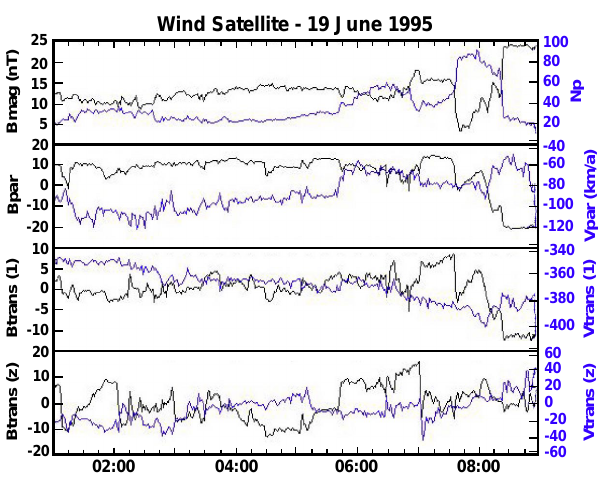
Fig. 13. PSD for Wind (top panel) and KIL (bottom panel) on 19 June 1995. Figure 13 shows the power spectral density (PSD) associ- ated with the parallel (compressional) component at Wind (top panel) and the H component at KIL (bottom panel). These are the same components as were used in Fig. 2 (top panel). The color scales are different in each panel in Fig. 13, in order to pull out the peaks in the spectrum. The KIL power bands are somewhat wider than those at Wind due to the resolution of the data. There are general trends in the two panels that are similar: an enhancement in power be- tween 0 and 4 mHz at the beginning of the plot; a depletion in PSD between 03:00 UT and 05:00 UT (top) and between 04:00 UT and 06:00 UT (bottom); and increased PSD be- tween 06:00 UT and 09:00 UT (top) and between 07:00 UT and 10:00 UT (bottom). The peaks in PSD occur in the fre- frequency for KIL ∼ 06:00 UT, ∼ 07:30 UT, and ∼ 09:15